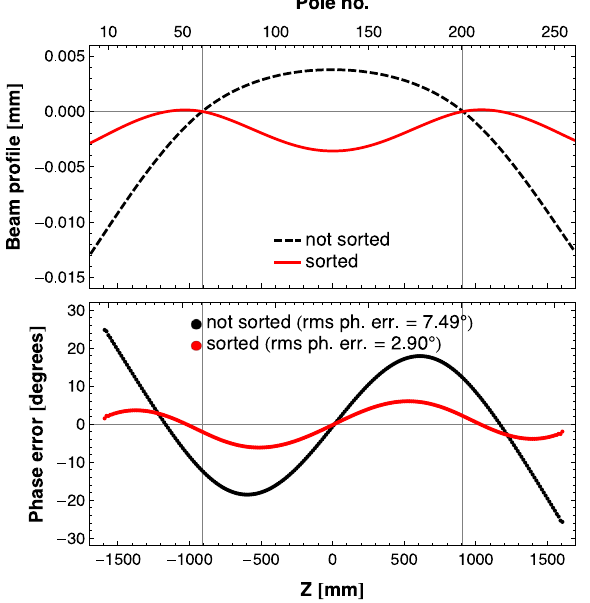
FIG. 9. Deformation of the strongback (top) and the resulting phase errors (bottom) vs distance along the undulator, for the set of random and systematic errors in spring unit strength of Fig. 8, and for the same set of errors after sorting. The vertical lines mark the actuator